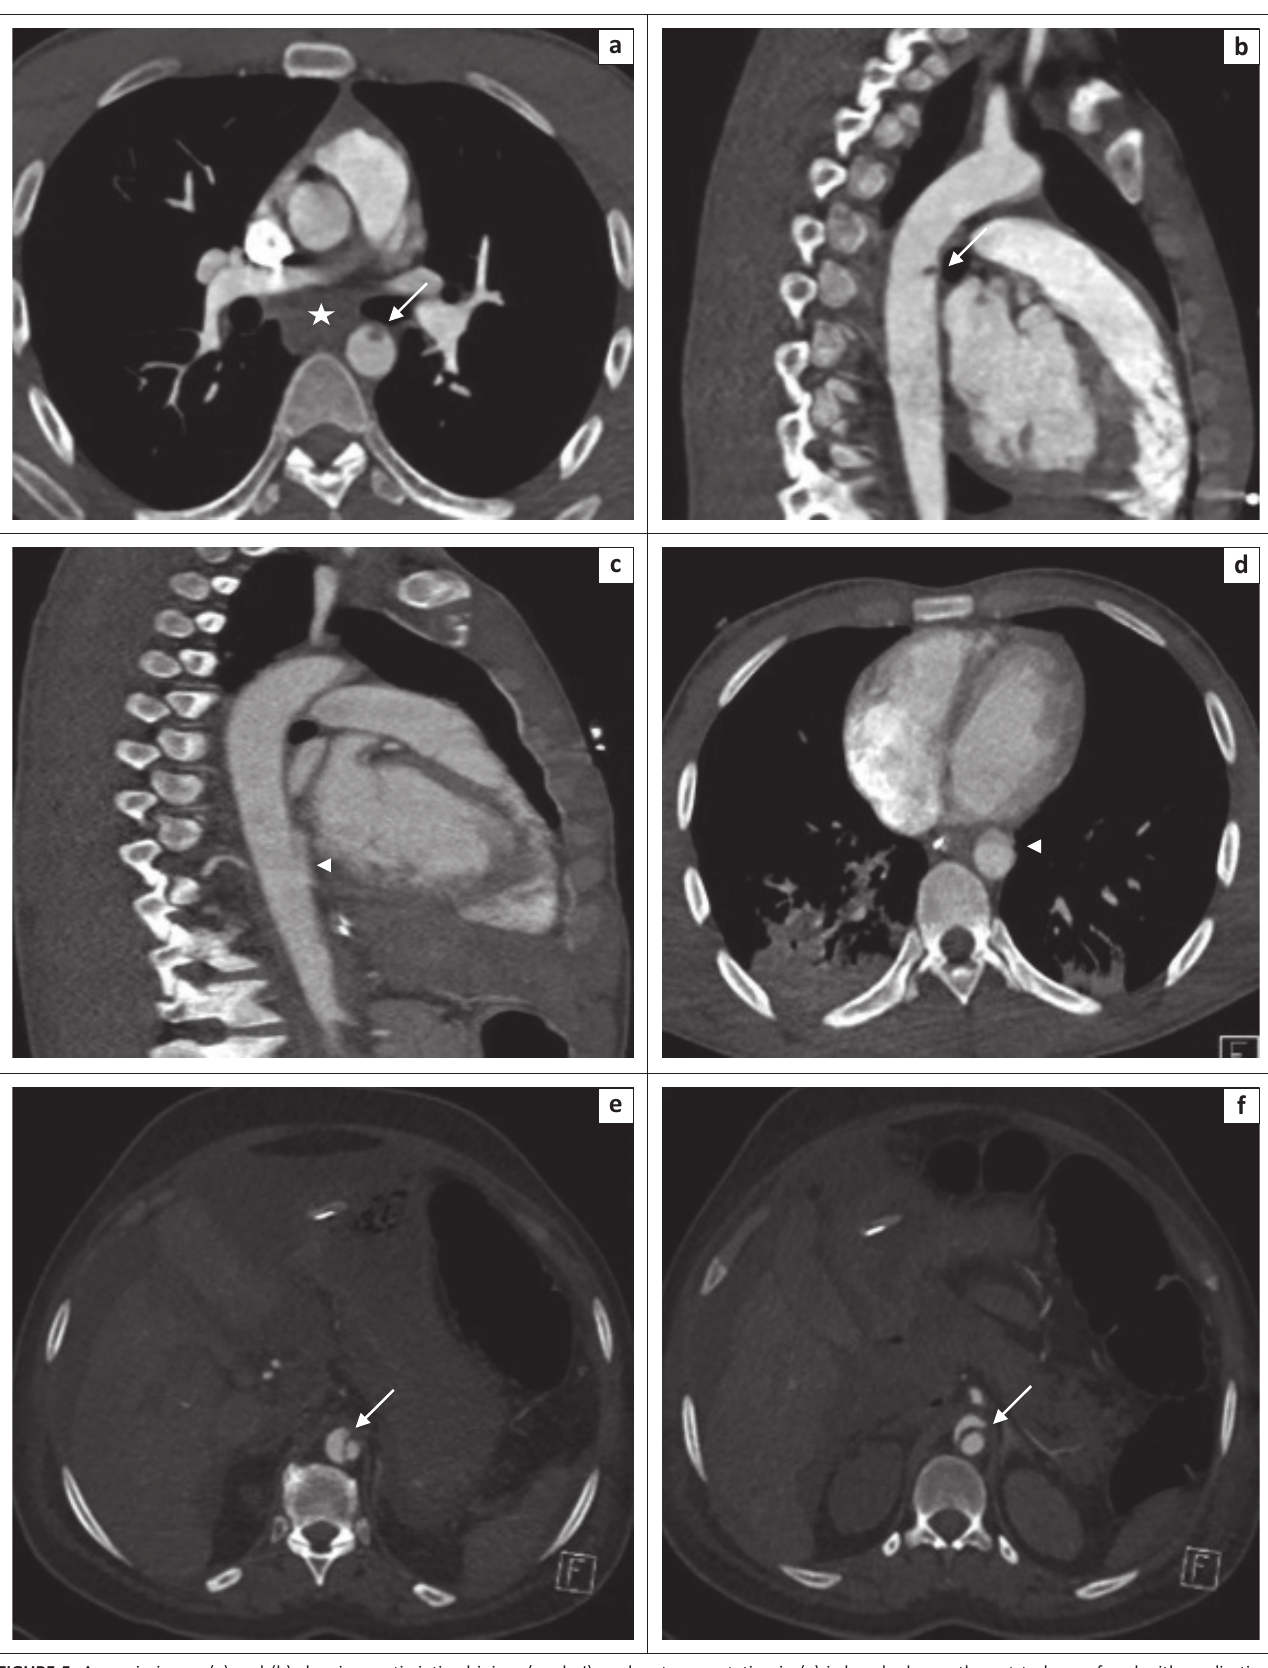
FIG URE 5: Arrow in image (a) and (b) showing aortic intimal injury (grade I), and a star annotation in (a) is lymphadenopathy not to be confused with mediastinal haematoma. Arrow heads in (c) and (d) demonstrate the lower thoracic aorta anterior wall irregularity (indirect sign) and an elongated intimal flap indicating a focal dissection (grade II). Arrows in another patient in (e) and (f) indicating a more conspicuous aortic dissection (grade II) at the level of the diaphragmatic